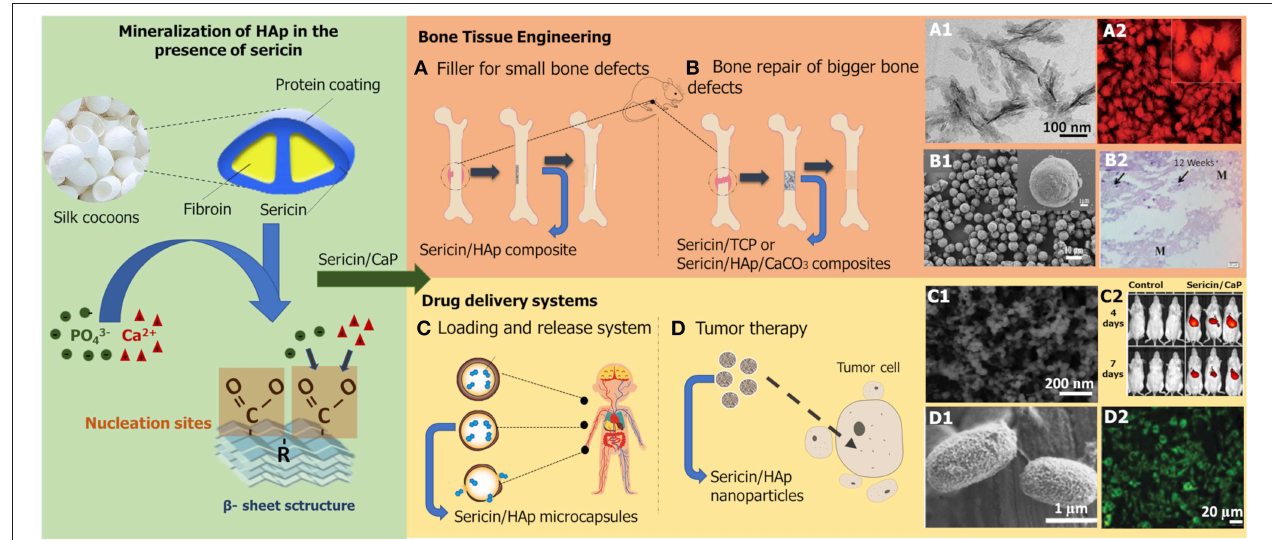
FIGURE 1 | Schematic representation of CaP mineralization process in the presence of sericin and research applications of sericin/CaP composites. Proposed biomineralization mechanism based on the works of Takeuchi et al. (2005b), Cai et al. (2009), and Veiga et al. (2019). (A1) Sericin/HAp composite particles, (A2) cell morphology and differentiation of MG-63 cells after 5 days of contact with the composite reproduced from Cai et al. (2009) with permission from Royal Society of Chemistry; (B1) sericin/CaCO 3 composite particles, (B2) mice tissue after 12 weeks of composite implantation reproduced from Zhong et al. (2016) with permission from Elsevier Science & Technology Journals; (C1) sericin/CaP composite nanoparticles, (C2) distribution of the composite in vivo reproduced from Zhao et al. (2017) with permission from John Wiley and Sons; (D1) sericin/HAp composite microcapsules, (D2) cell adhesion activity on HapG-2 cells after 7 days of contact with the composite reproduced from Li et al. (2016) with permission from Royal Society of